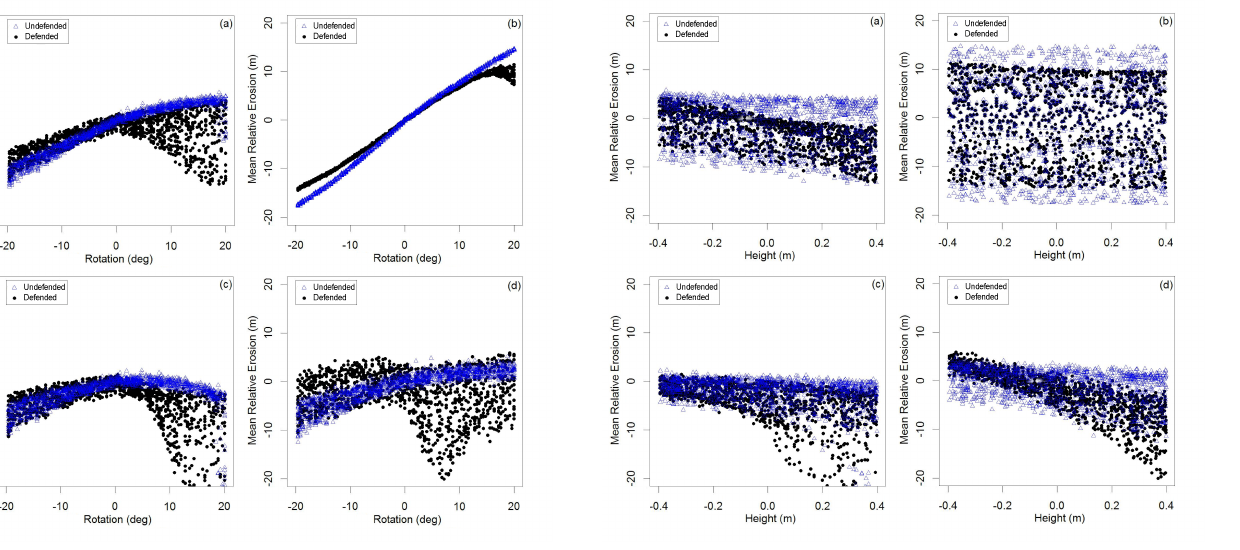
Figure 4. Perturbation in wave direction plotted against spatially averaged mean relative erosion for (a) the entire coast, (b) the north- ern section (1), (c) the central section (2), (d) and the southern sec- tion (3). Counterclockwise rotation of wave direction is negative, clockwise rotation is positive. Negative values in mean relative ero- sion indicate a reduction in coastal erosion in comparison to the baseline simulation.